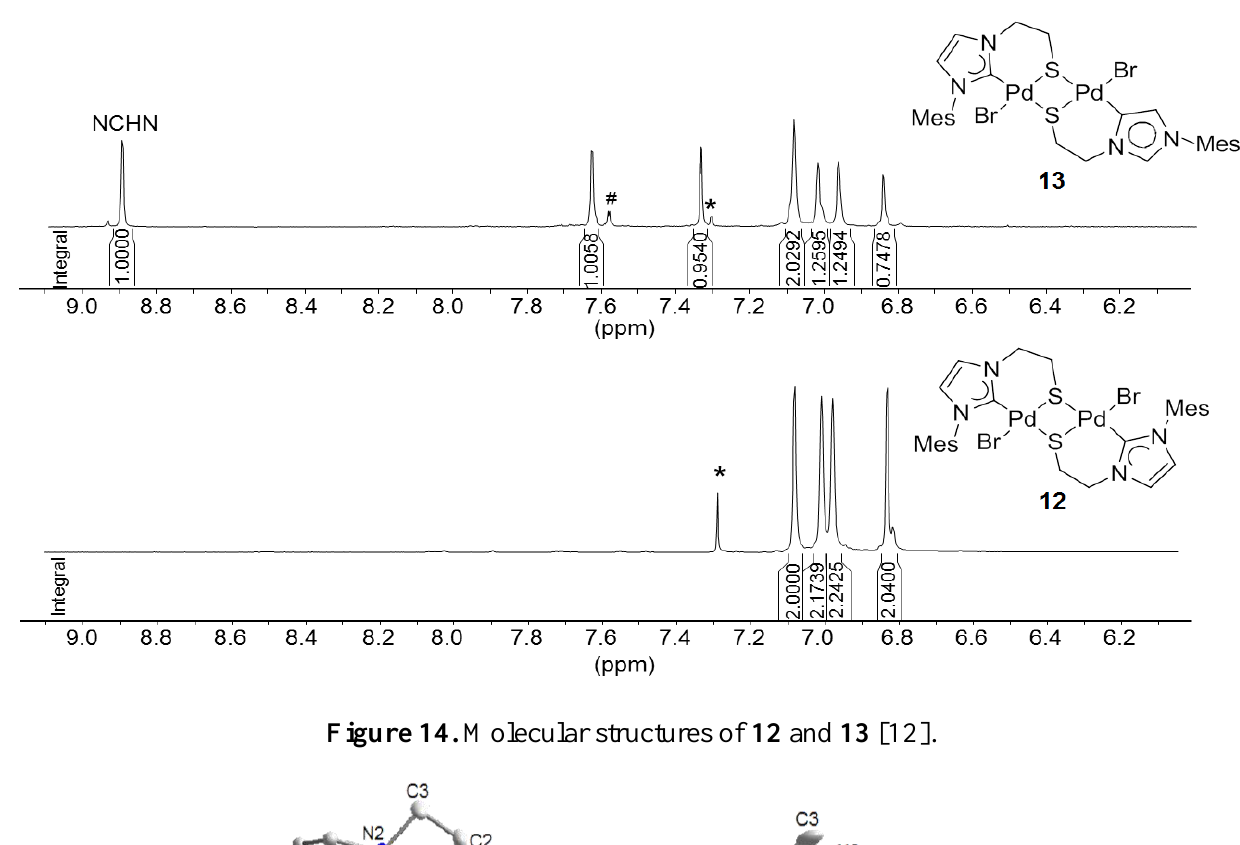
Figure 13. Comparison of aromatic signals of 1 H-NMR spectra of 12 (500 MHz, CDCl and 13 (500 MHz, DMSO- d6 ). The peaks marked with * correspond to solvents and the one with # is due to the impurity.